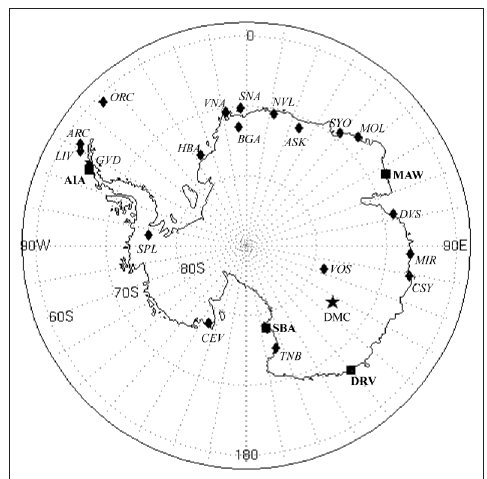
Fig. 1. Location of magnetic observatories in Antarctica. Square: Intermagnet observatories; dia- mond: observatories with various status; star: DomeC